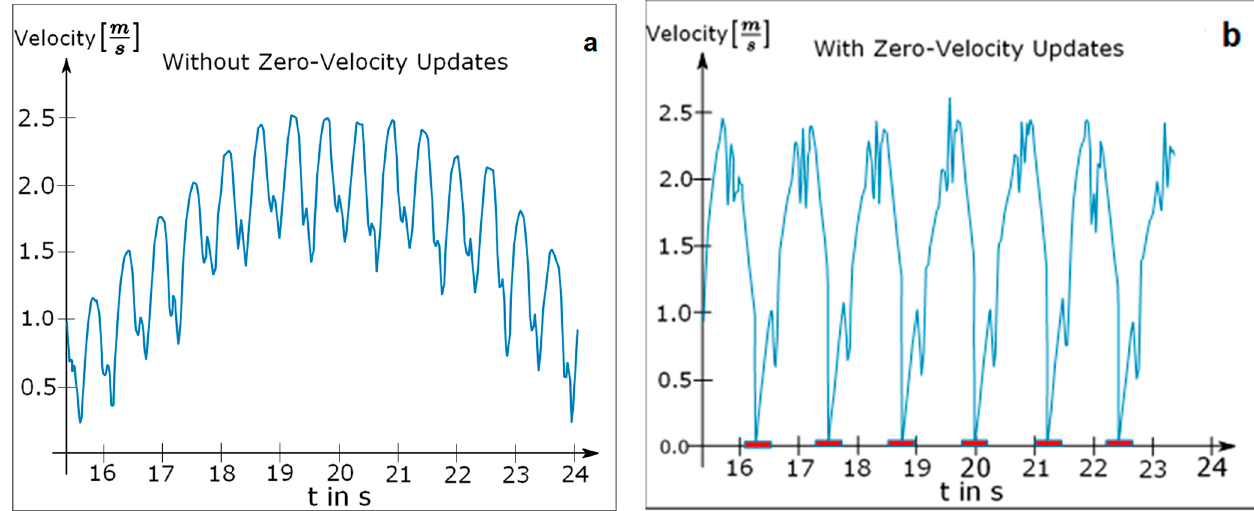
Figure 4. ( a ) Velocity curve of a single foot without zero velocity updates; ( b ) velocity curve of a single foot with zero velocity updates.